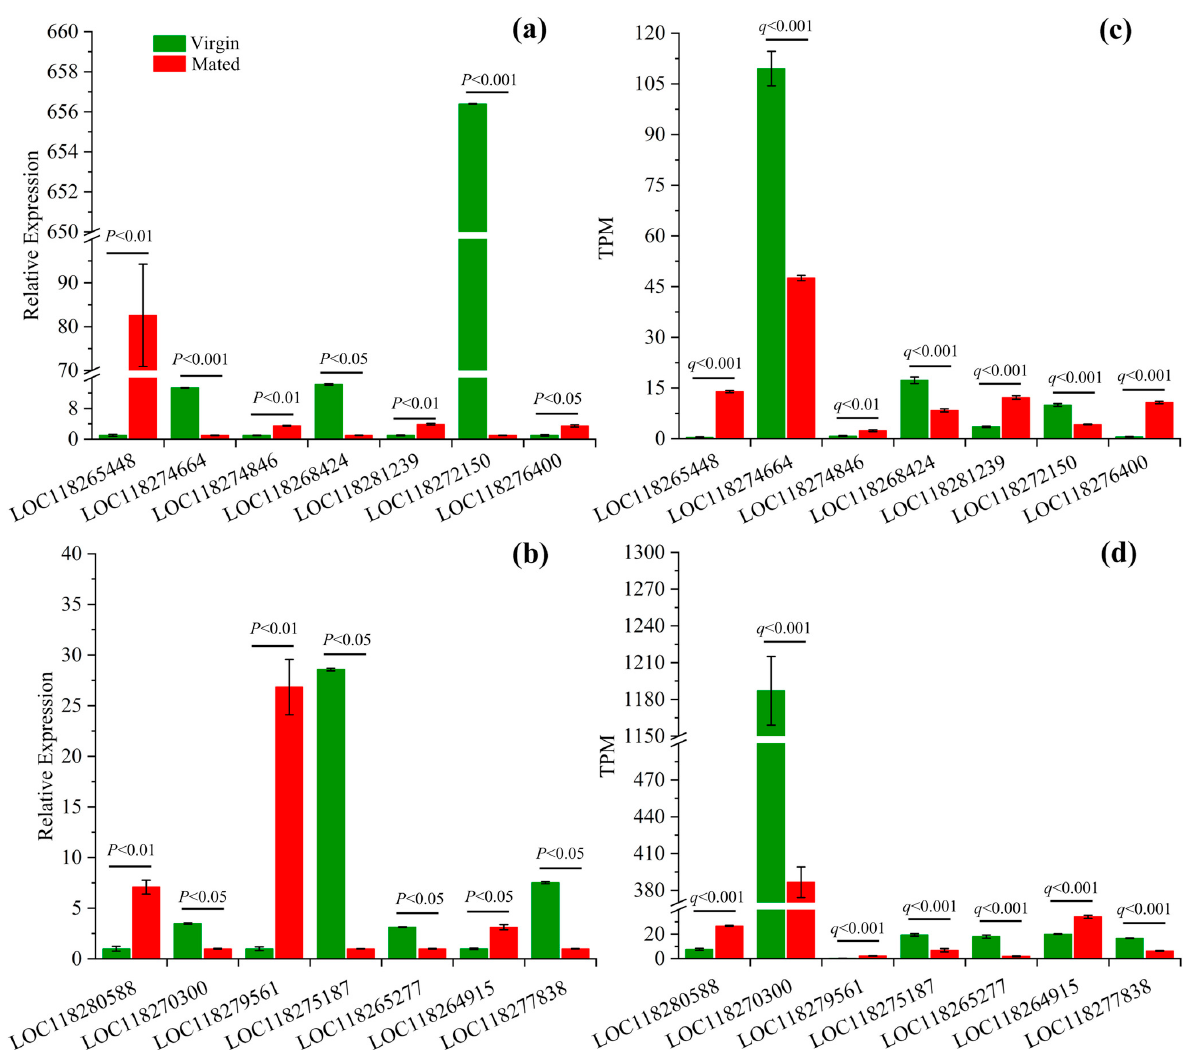
Figure 6. Transcriptome validation for DEGs by qPCR. ( a ) relative expression levels of target genes in females measured by qPCR and ( c ) their expression levels measured by RNAseq; ( b ) relative expression levels of target genes in males measured by qPCR and ( d ) their expression levels measured by RNAseq.